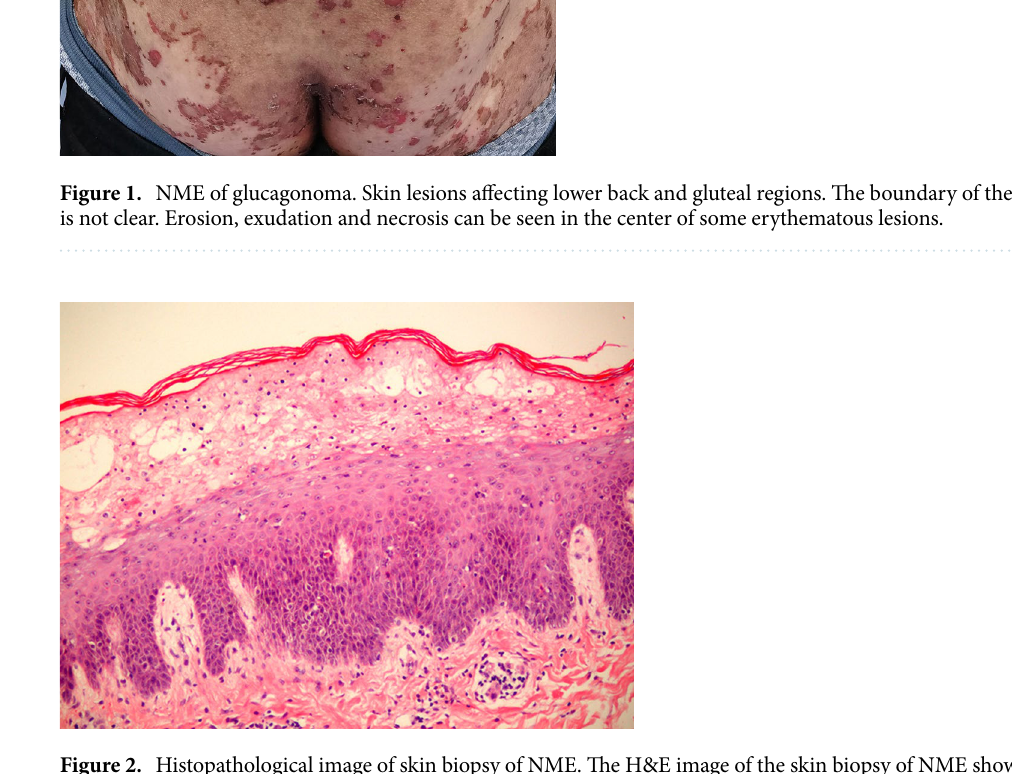
Figure 2. Histopathological image of skin biopsy of NME. The H&E image of the skin biopsy of NME showed mild hyperplasia of the epidermis and abundant lymphocyte infiltration (×